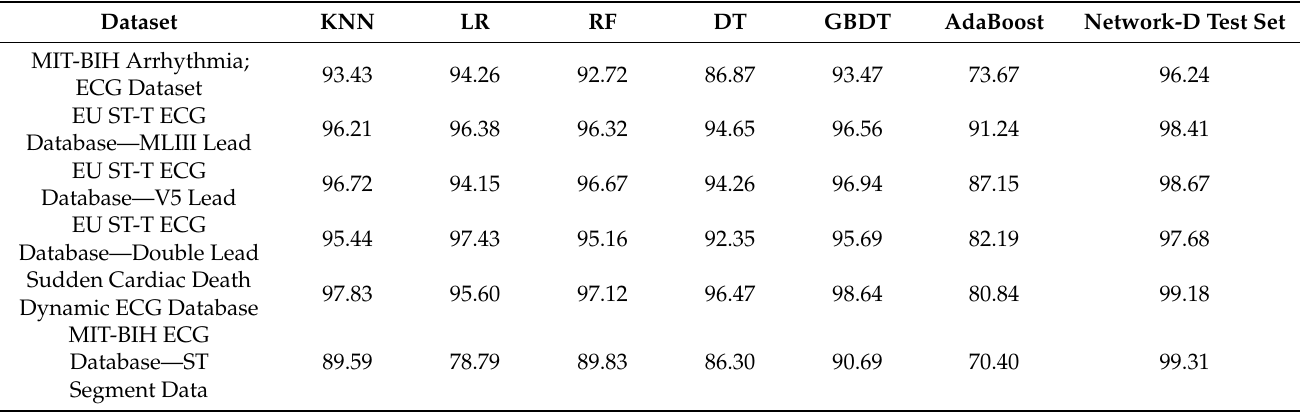
Table 8. Accuracy of each classifier on all